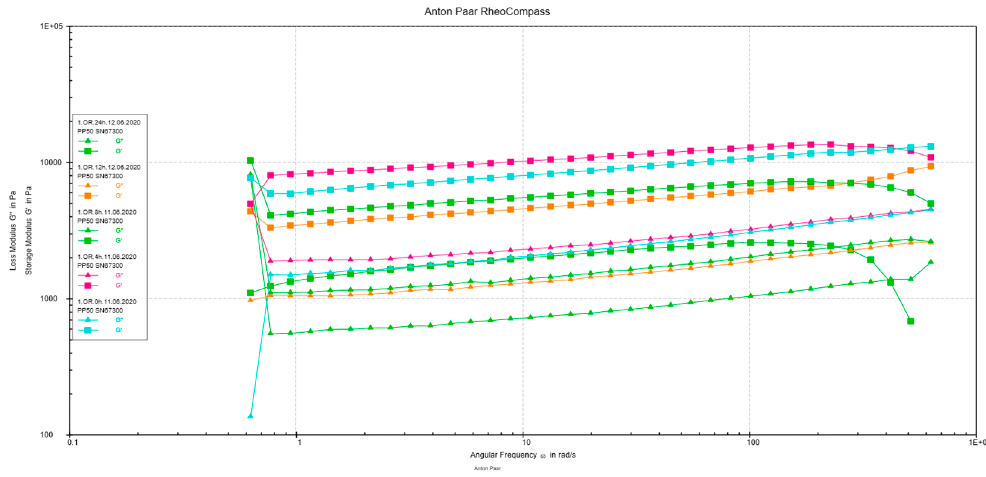
Figure 6. The storage (G’) and loss (G”) shear moduli for OR sourdough at different fermentation times: 0, 4, 8, 12, and 24 h.